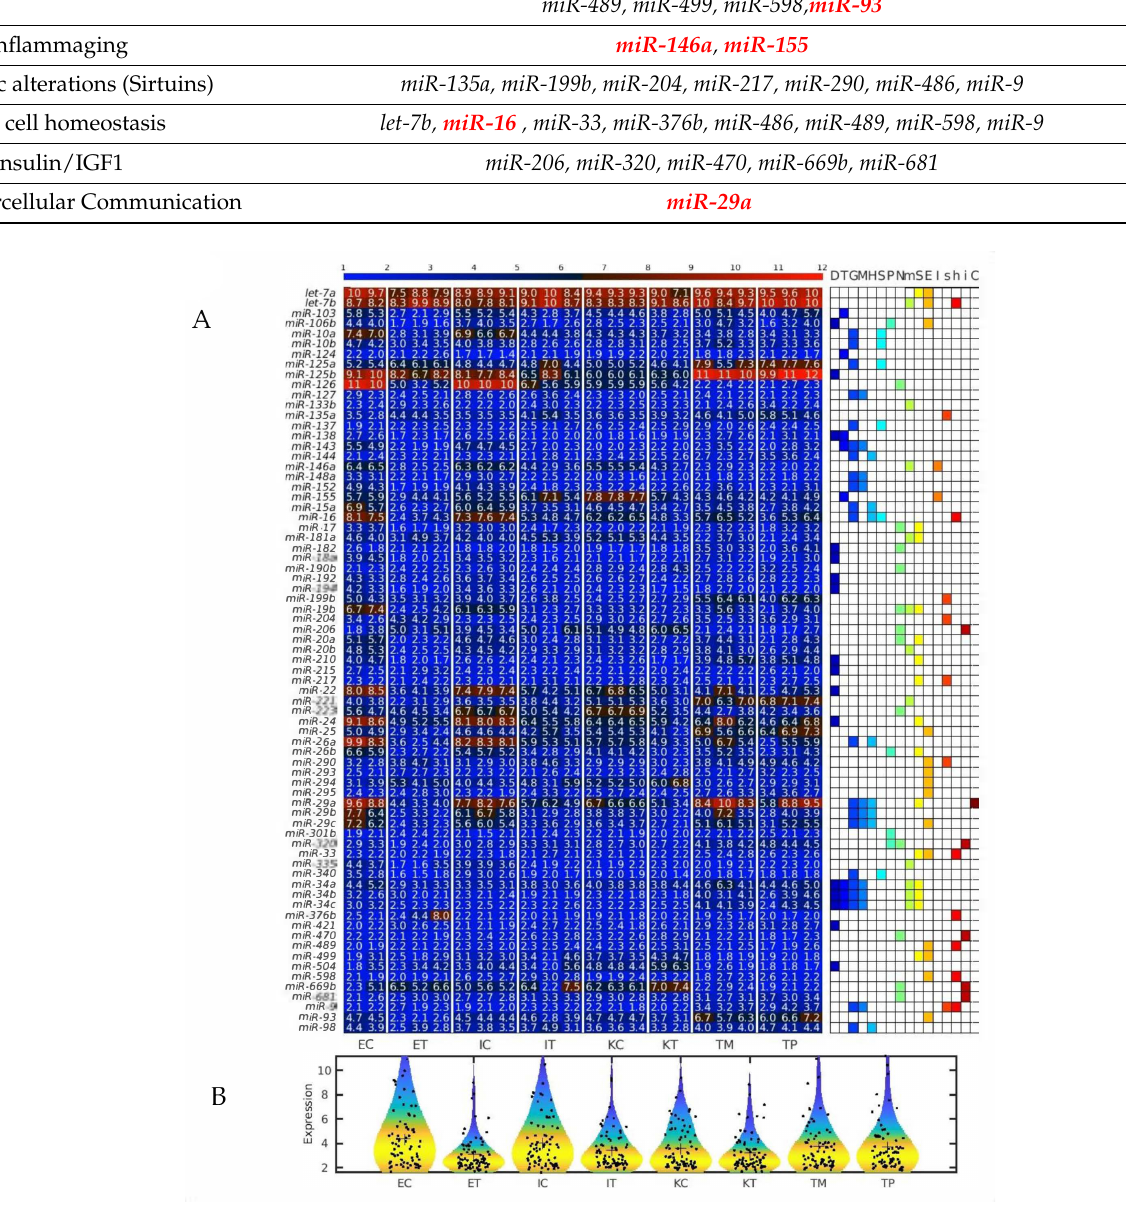
plots of the expression distribution of the miRNAs associated with the hallmarks of eukaryotic aging. The crosses represent the position of the means, while the black points represent the spread of the expression of the miRNAs used to build the